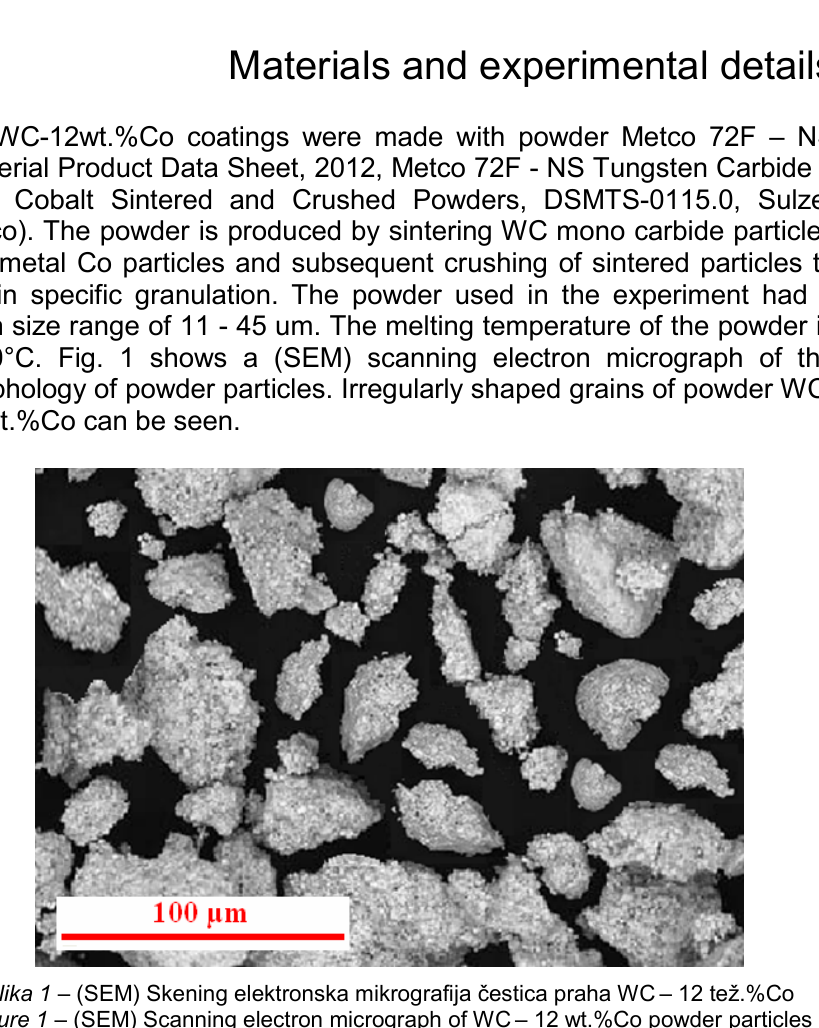
Figure 1 – (SEM) Scanning electron micrograph of WC – 12 wt.%Co powder